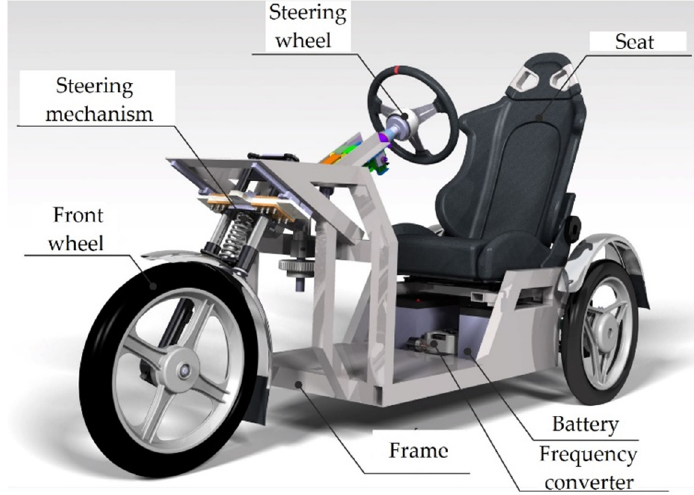
Figure 1. Three-dimensional CAD model of the prototype—E3-cycle.